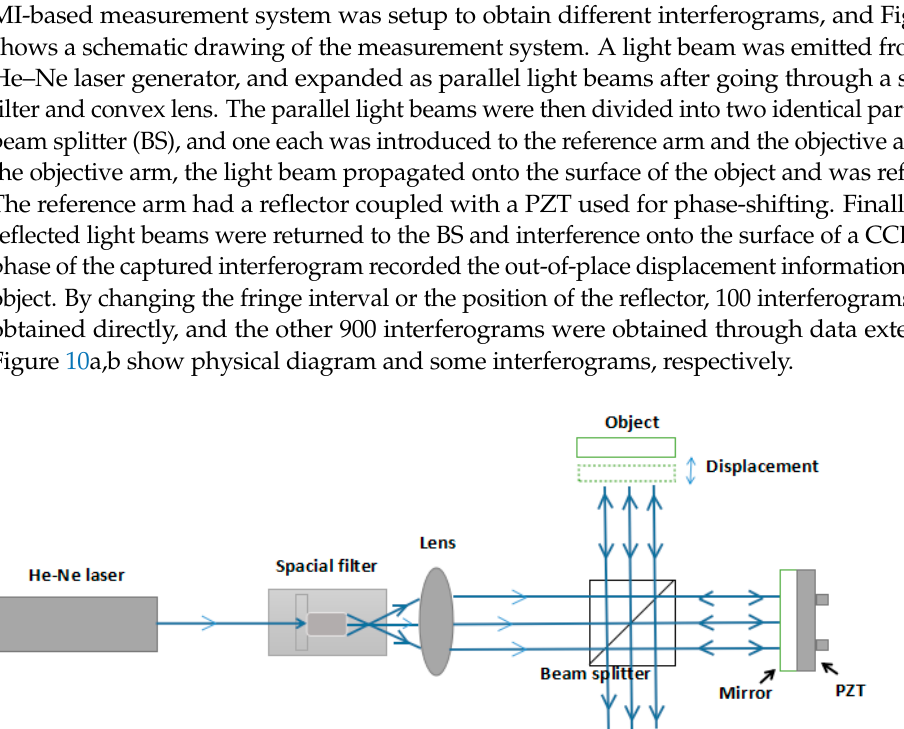
Figure 10. ( a ) Physical diagram. ( b ) Interferograms. The 100 fringe patterns from the fringe projection experiment and 100 interfero- grams were selected to evaluate the trained network, and the remainder was used to